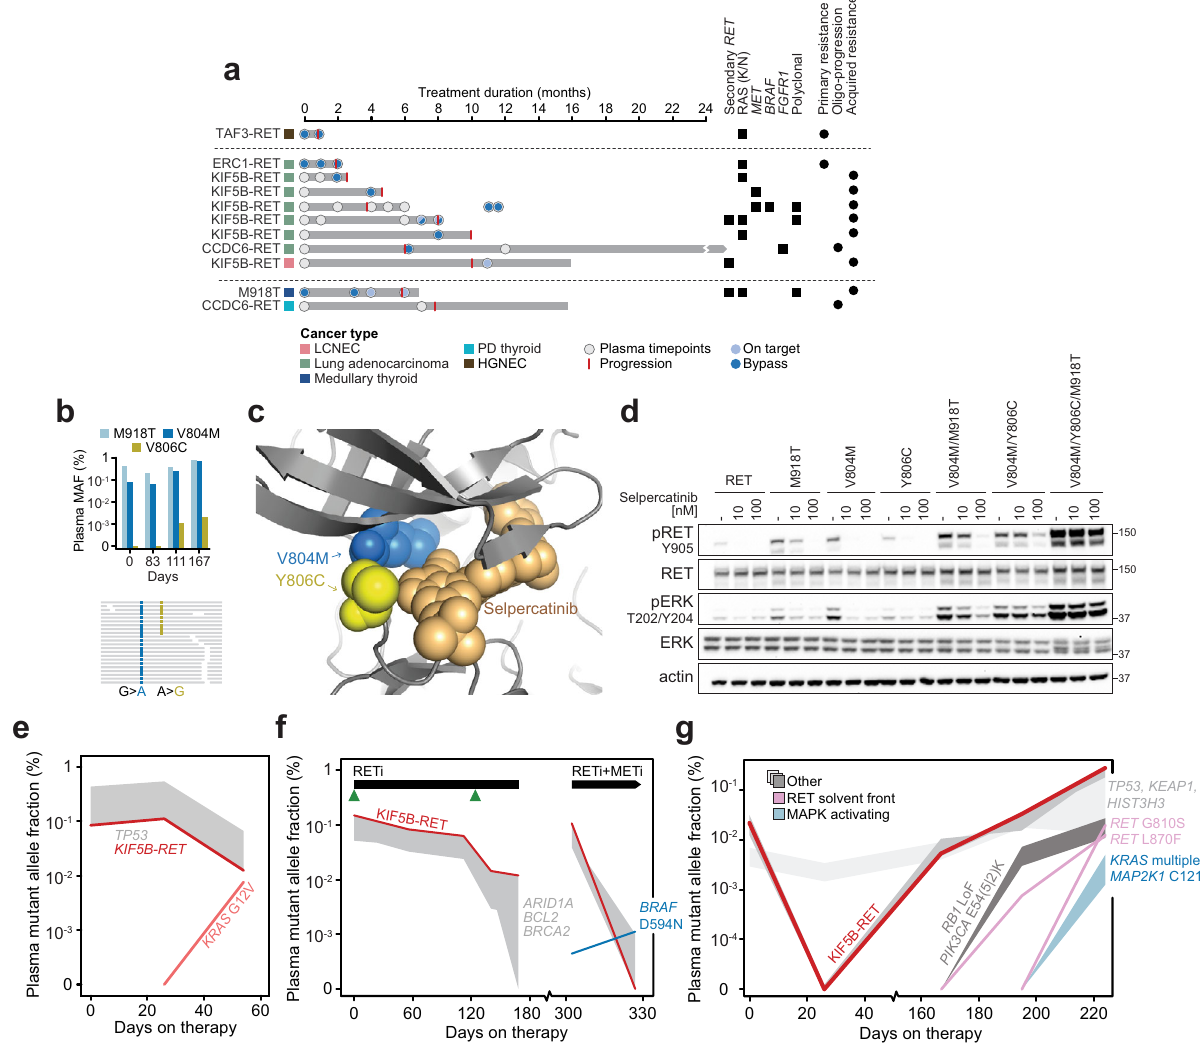
Fig. 3 Mechanisms of RET inhibitor resistance. a Selpercatinib-treated patients with either primary resistance, oligo-progression, or acquired resistance are shown indicating the duration of treatment response (arrows: ongoing) along with plasma sequencing time points and identi fi ed mechanism(s) of resistance (see legend). b Plasma RET M918T, V804M, and V806C mutant allele frequencies (top) and sequencing reads re fl ecting cis -acting mutants at progression timepoint (bottom). c The structure of RET bound by selpercatinib (as indicated) with cis V804M and Y806C composite mutations. d In 293T cells, expressing double in cis mutants ( RET V804M/Y806C) reduced sensitivity to selpercatinib as measured by the dose-dependent decrease of both pRET and pERK by western blot. The triple cis mutant RET M918T/V804M/Y806C was resistant to selpercatinib ( n = 2 experiments). e Longitudinal plasma cfDNA pro fi ling indicates the RET fusion-positive and PIK3CA -mutant clone responding with a likely RET -wild-type KRAS G12V subclone emerging at resistance (independent cellular populations represented by shading which signi fi es the minimum and maximum allele frequency detected in each independent subclone). f As in panel ( e ) but for a patient with a subclonal MET ampli fi cation (green) that is selected for by selpercatinib therapy despite reduction of the RET fusion in plasma. Subsequent combined MET and RET inhibition selects for the outgrowth of a BRAF D594N-mutant subclone. g As in panel ( e ) but for a patient with a complex pattern of polyclonal resistance with cell populations emerging mediated by distinct and non-overlapping on- target and bypass mechanisms of selpercatinib